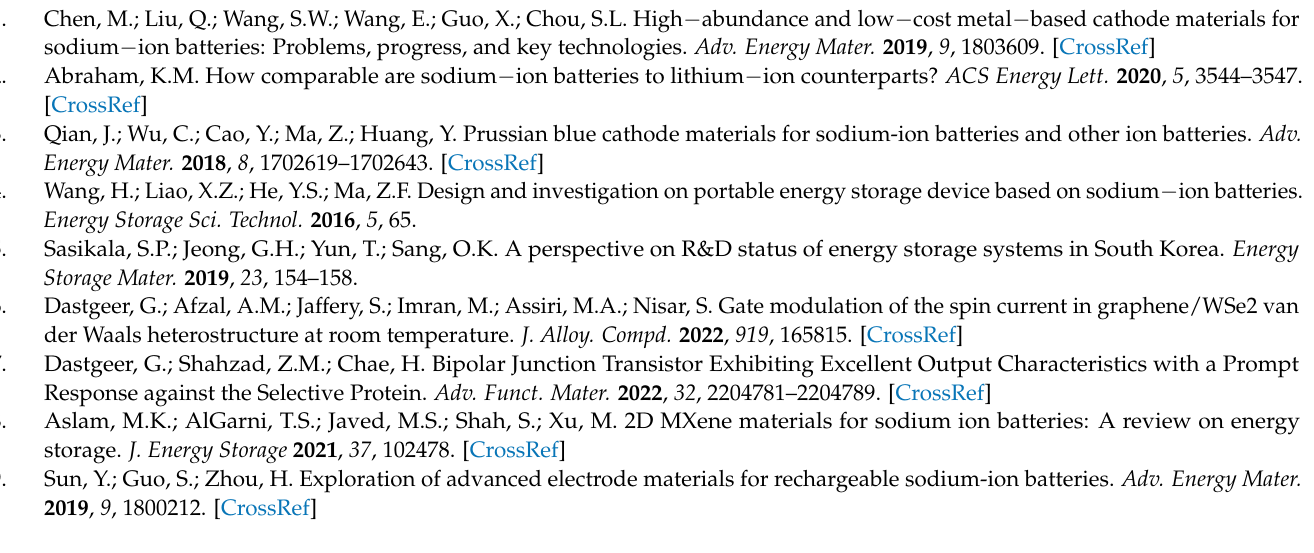
of KCoHCP − CP − EK. Figure S6: The cycling performance of KCoHCP − Hx − EK at a current density of 0.1 A · g − 1 . Figure S7: The rate performance of KCoHCP − Hx −